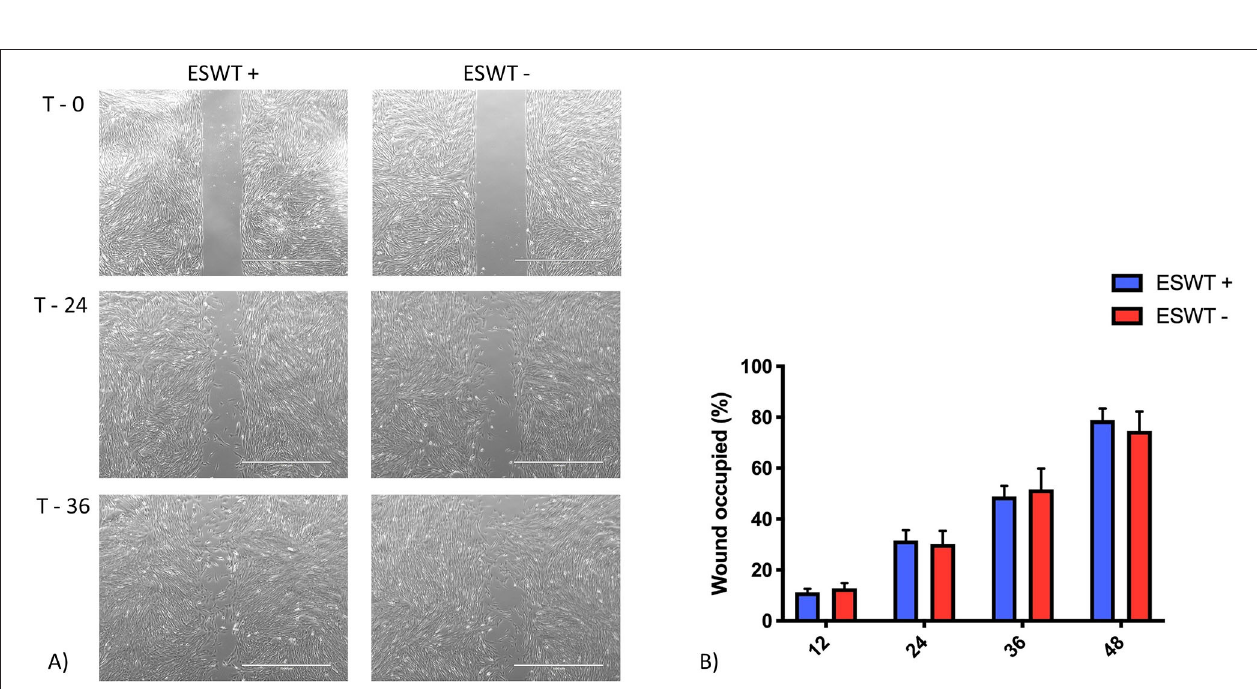
FIGURE 5 | Migration. (A) Representative scratch assay for treated (ESWT + ) and untreated (ESWT–) equine CB-MSC. Images were obtained using a motorized inverted microscope until closure of the scratch in the cell layer. (B) Percentage of wound occupied, calculated by dividing the none recovered area at 12, 24, 36, and 48h, respectively by the initial wound area at 0h and subtracting this value as a percentage from 100%. There were no differences ( p > 0.05) between the treated (ESWT + ) and untreated (ESWT–) equine CB-MSC at each time point.